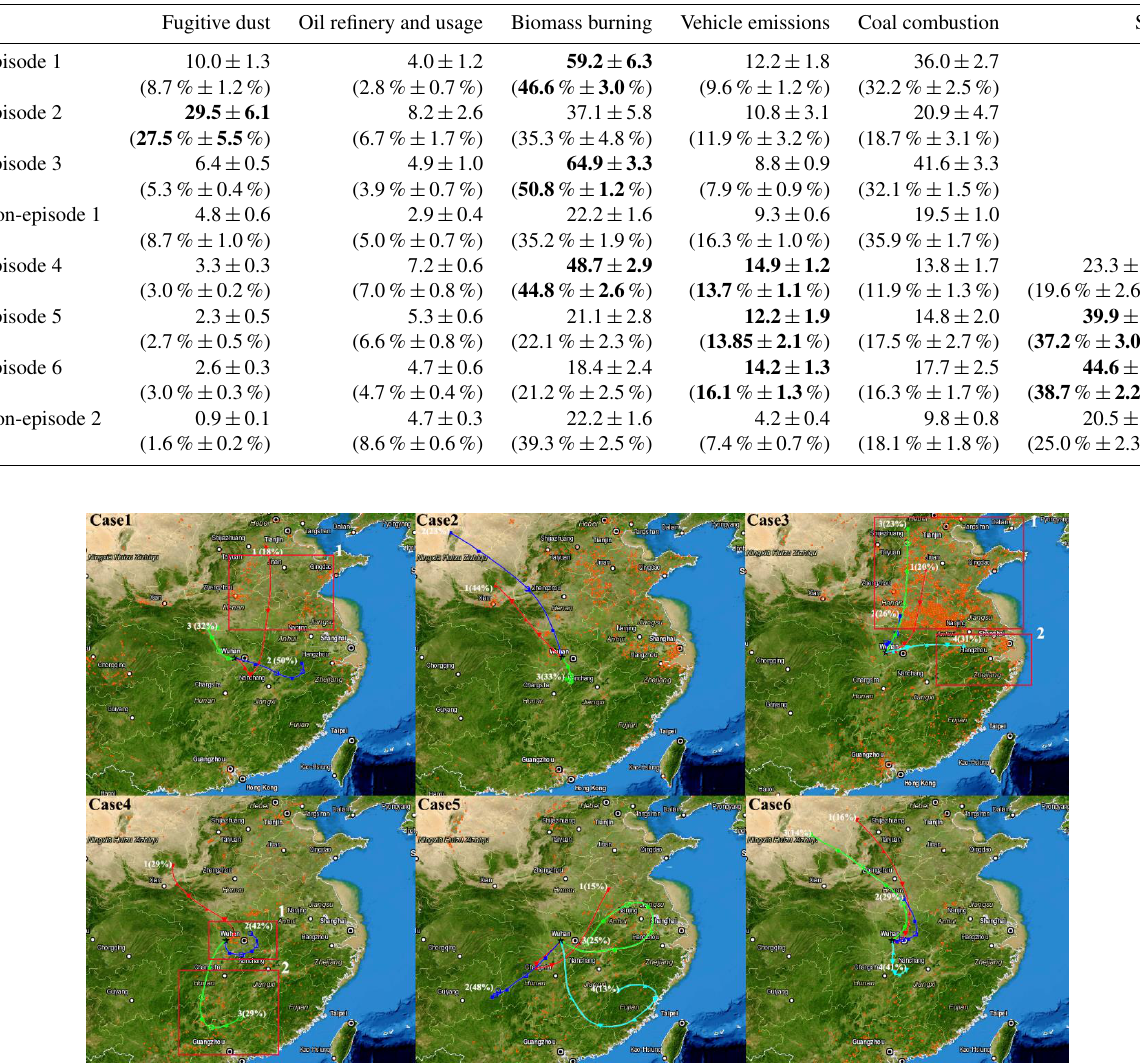
Table 4. Mass concentration (µgm − 3 ) and percentage contribution (in parentheses) of sources to sum of resolved species in PM 2 . 5 . Bold font represents a significant increase in percentage contribution in episodes compared to non-episodes.